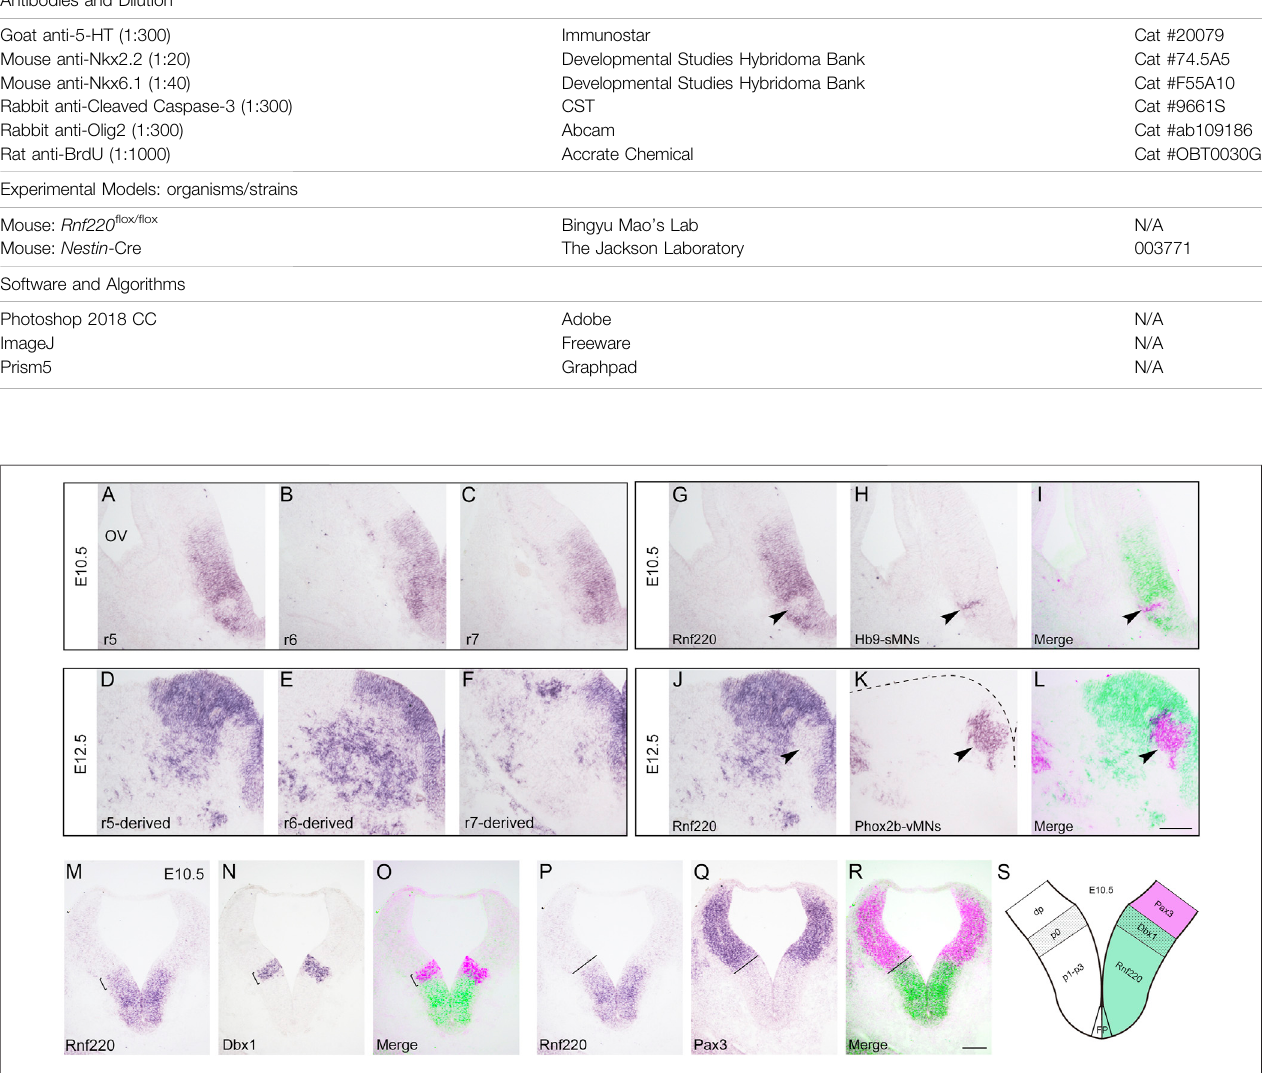
Frontiers in Cell and Developmental Biology |